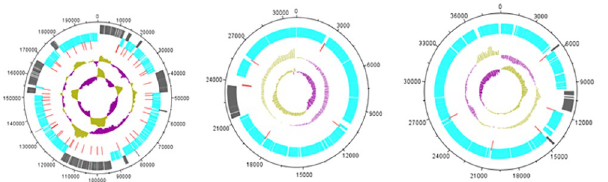
Fig 5. Genome maps of bacteriophages vB-VmeM-32, vB_EauS-123 and vB_BhaS-171 respectively, drawn to scale. First track show forward transcribed ORFs and second tracks show reverse transcribed ORFs respectively. Third track shows terminators (red). Moving inward, the track show the %GC content (purple = low %GC) and innermost of the genome map GC skew ([G-C]/[G+C]).